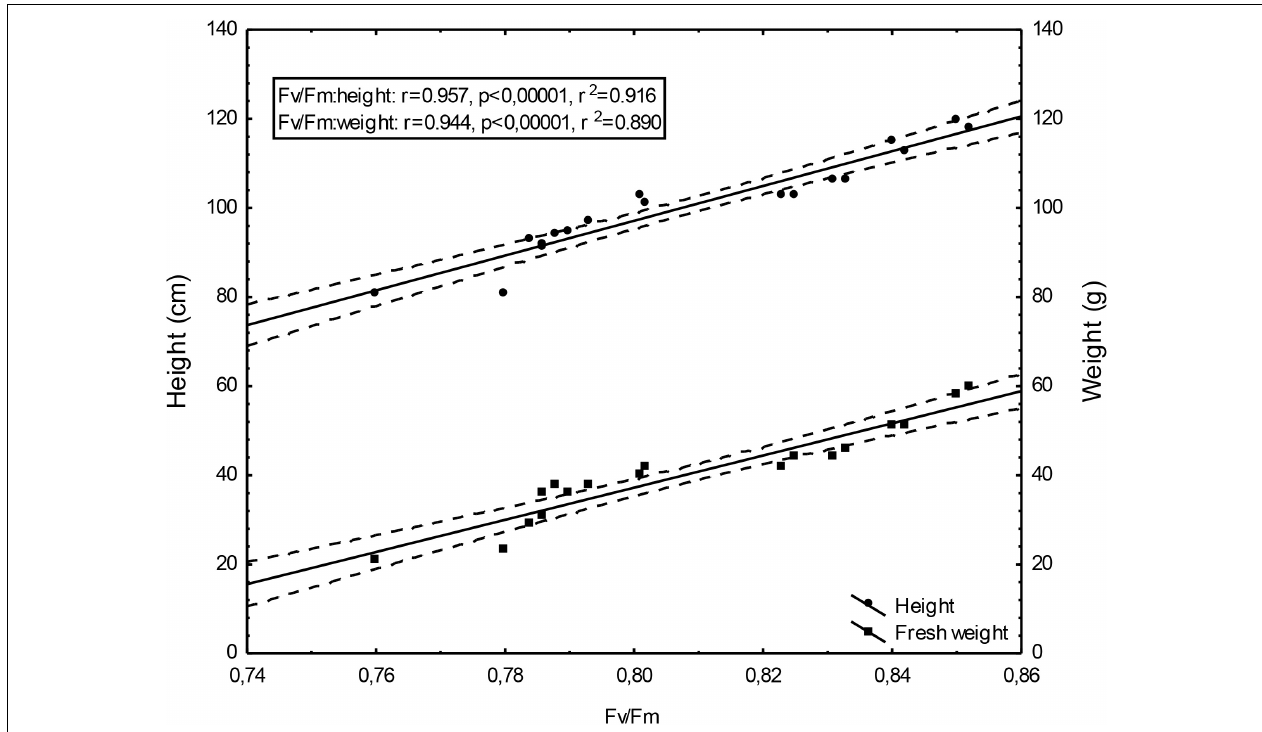
FIGURE 5 | Height and fresh weight regressions against Fv/Fm: height = –215.27 + 390.48Fv/Fm and weight = –251.40 + 360.79Fv/Fm; 0,95 C.L. (Confidence limit).